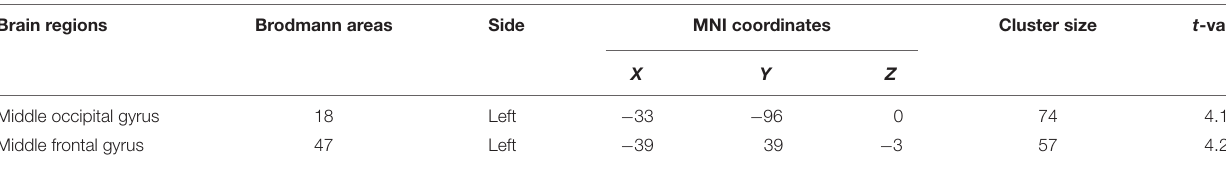
TABLE 6 | Brain regions in ReHo between post- and pre-rTMS.